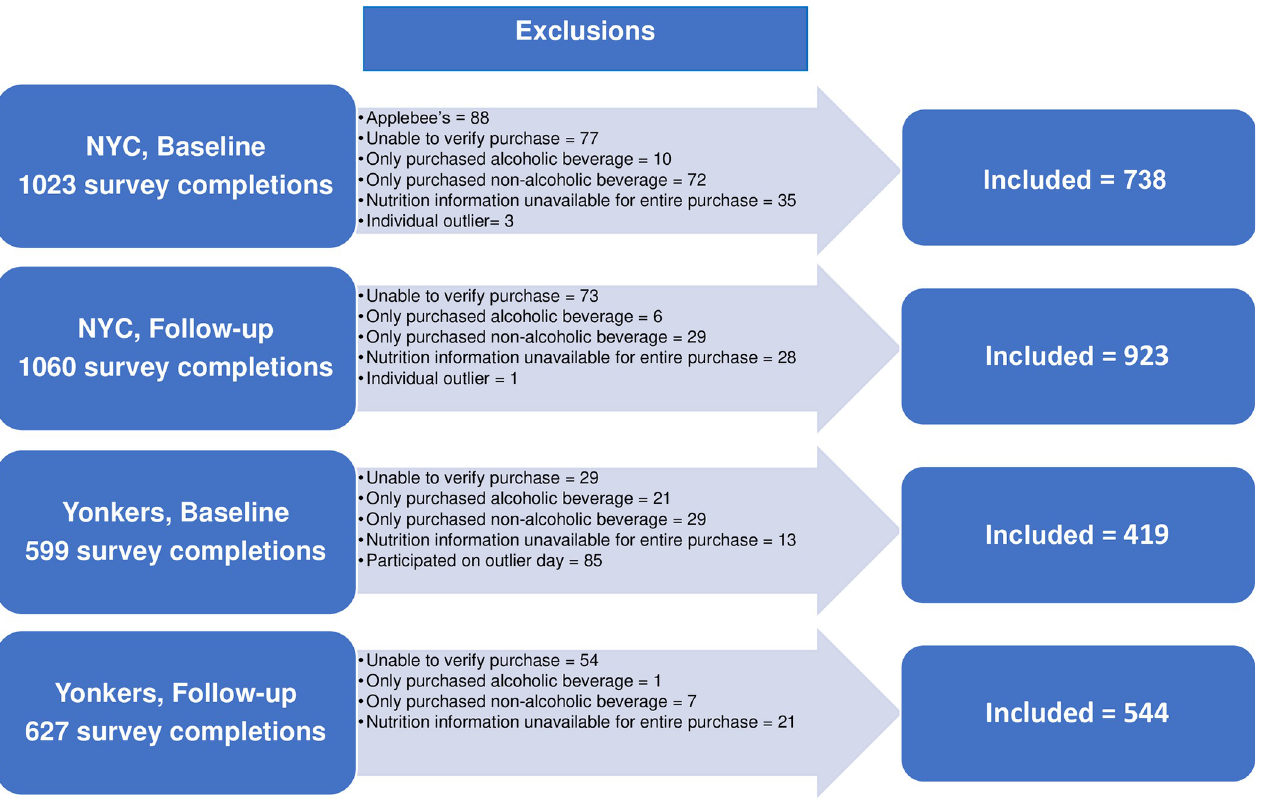
Fig 1. Participant flow chart, full-service